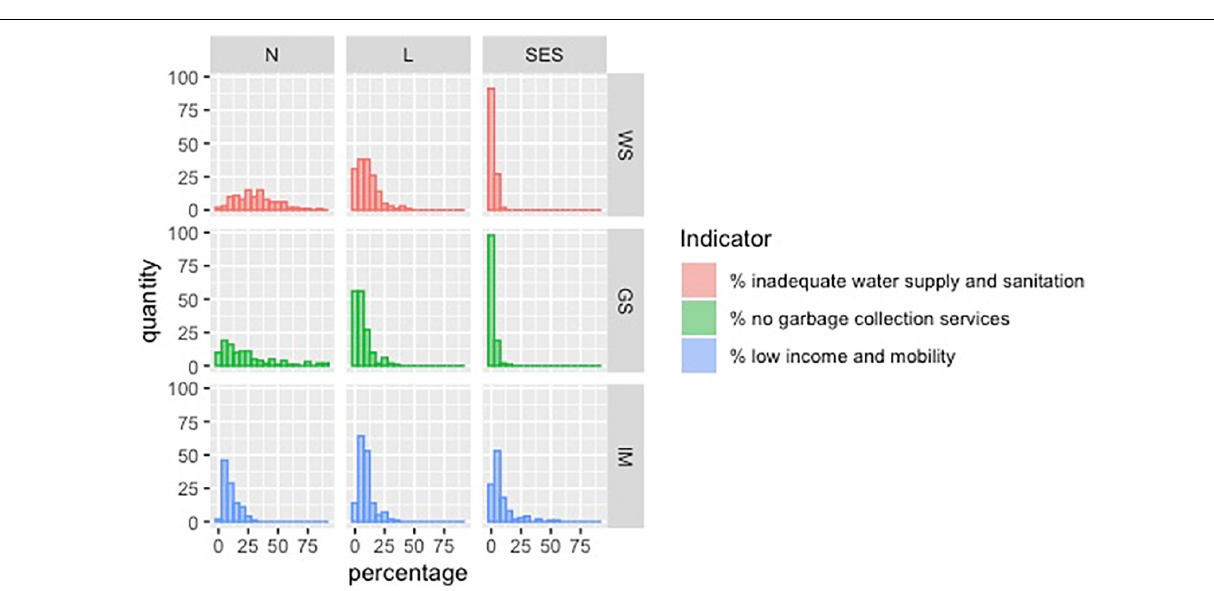
FIGURE 12 | Histogram of the municipal distribution based on the SVI Urban Infrastructure indicators. Elaborated by the authors with data from IPEA